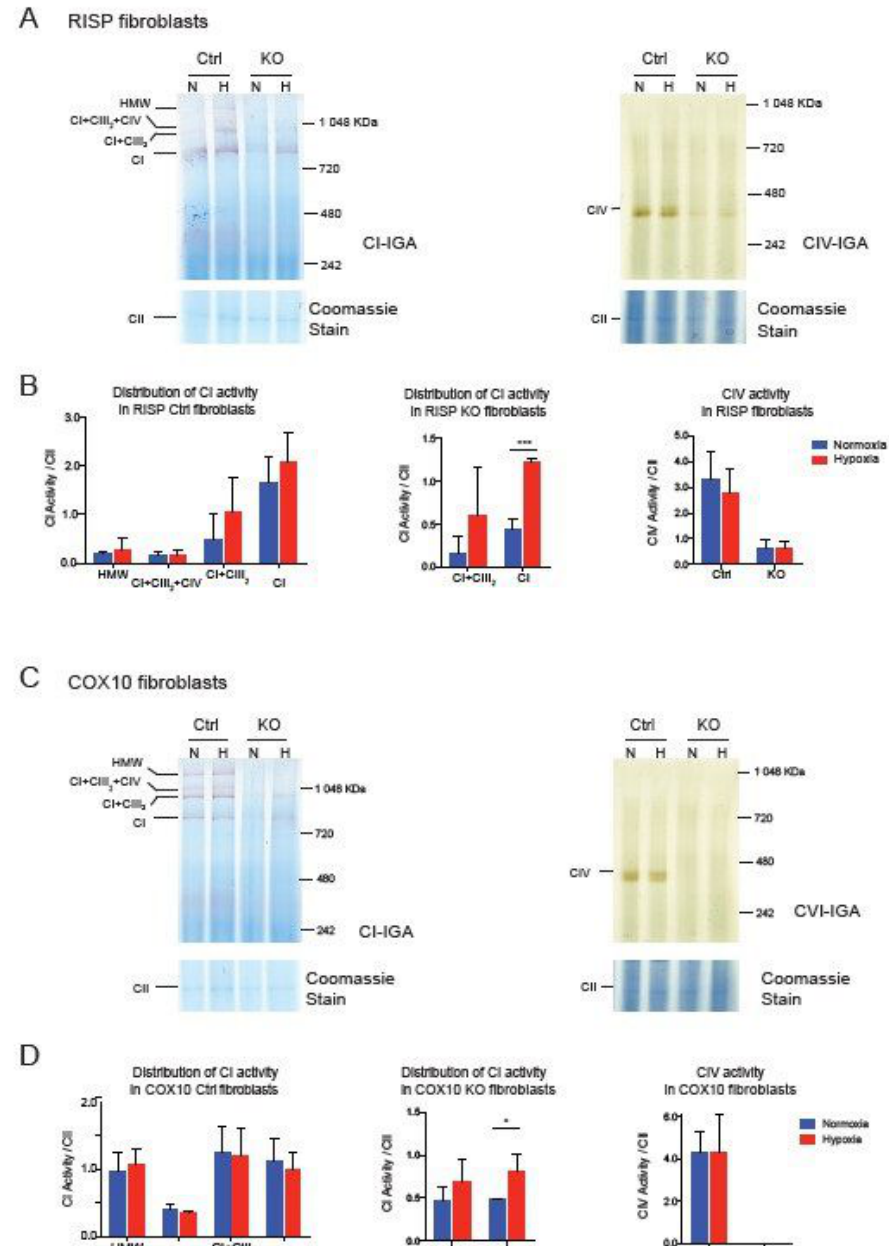
Figure 5. E ff ect of hypoxia on CI and CIV activity in RISP and COX10 fibroblasts. ( A ) Control and RISP KO lung fibroblasts were exposed to 1% oxygen for 24 h and cell processed and OXPHOS complexes separated by BN-PAGE. Then in gel activity stain (IGA) was performed with appropriate substrates for CI and CIV, respectively. After the activity stain, gels were stained with Coomassie blue to visualize all OXPHOS complexes. ( B ) Quantification of IGA for CI and CIV by densitometry using ImageJ software. Values of the activity stain were normalized to the CII band as protein loading control after gels were stained with Coomassie blue. Statistical di ff erences were determined using Student’s t -test ( n = 3). Statistical significance was represented by *** p < 0.001. ( C ) Control and COX10 KO skin fibroblasts were exposed to hypoxia, and IGA was performed as described in ( A ). ( D ) Quantification of IGA for CI and CIV by densitometry as described in ( B ). Statistical significance after Student’s t -test is represented by * p < 0.05 ( n =